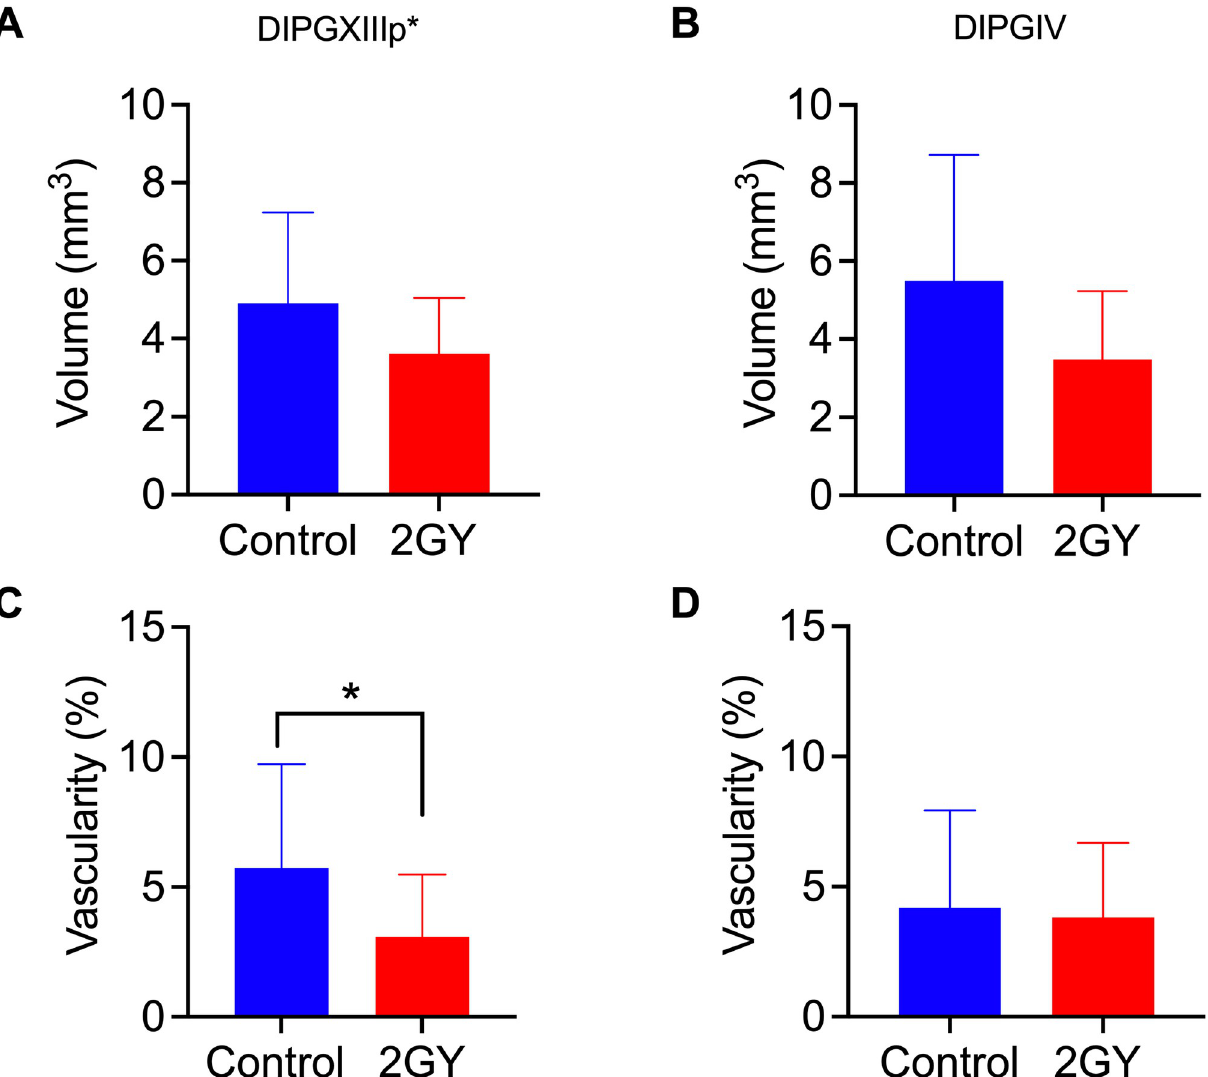
Fig 5. Volumetric and vasculature analysis of DIPG CAM tumors. DIPGXIIIp � and DIPGIV CAM tumors underwent a single dose of 2Grey radiation treatment on embryonic development day 13 and were analyzed by 3-D ultrasound on embryonic development 16. DIPGXIIIp � and DIPGIV CAM tumors were analyzed for differences in volume (A, B, respectively) and vascularity (C, D, respectively). Differences were analyzed by Student’s T-Test where P < 0.05. � = P < 0.05, �� = P < 0.001, ��� = P < 0.0001.